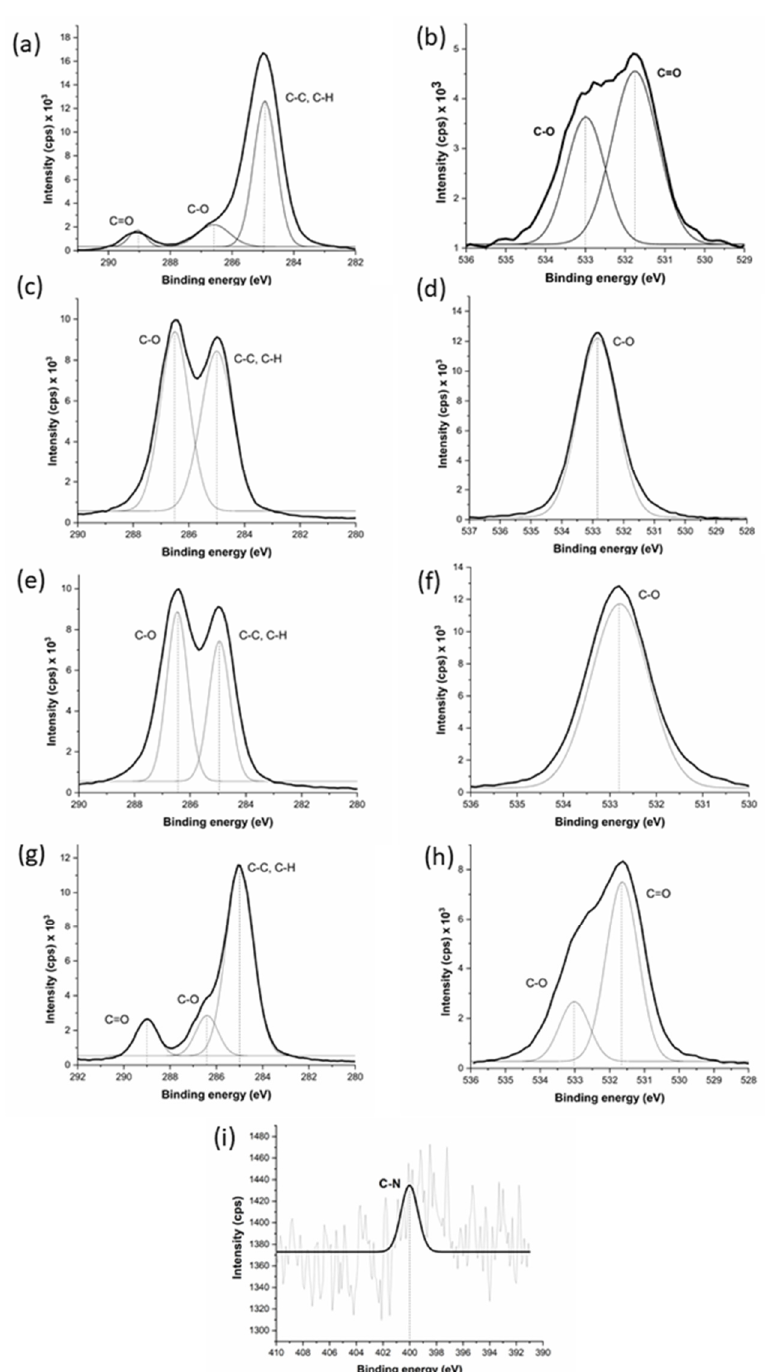
Figure 5. XPS high resolution spectrums and deconvoluted peaks for: ( a ) PCL membrane C 1s ; ( b ) PCL membrane O 1s ; ( c ) PVA membrane C 1s ; ( d ) PVA membrane O 1s ; ( e ) PVA:Gly membrane C 1s ; ( f ) PVA:Gly membrane C 1s ; ( g ) core-shell membrane C 1s ; ( h ) core-shell membrane C 1s ; and ( i ) PVA:Gly membrane N 1s .